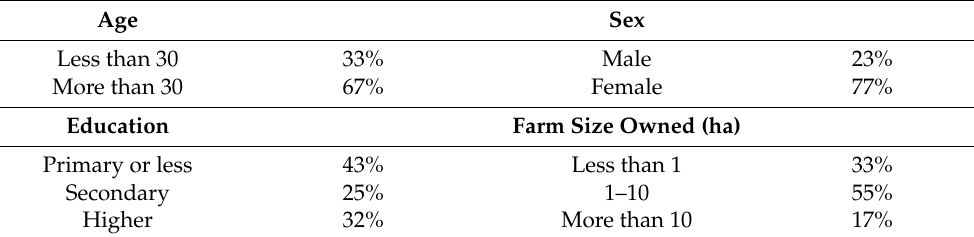
Table 2. Demographic characteristics of the